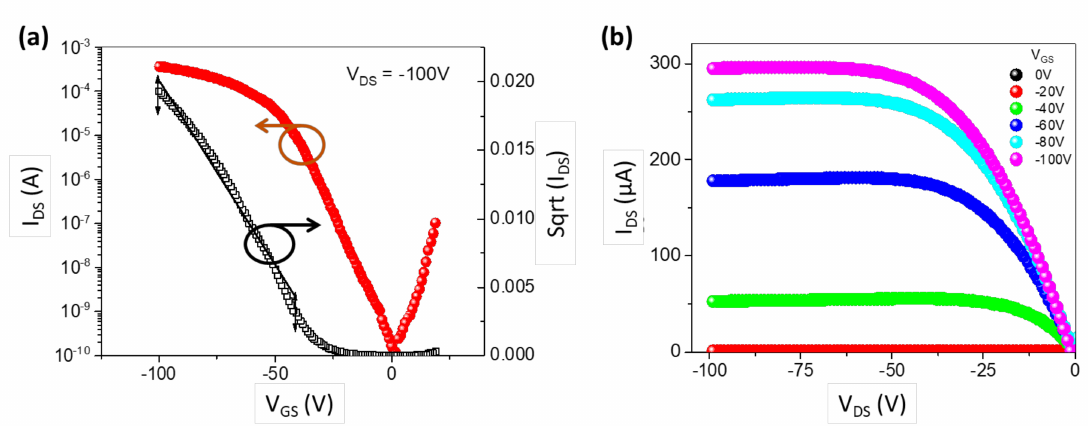
Figure 2. ( a ) Transfer characteristics of the light-emitting field-effect transistor (LEFET) (red) and the square root of the source-drain current (black) with a linear fit for channel length L = 100 µ m, and channel width = 2400 µ m. ( b ) Output characteristics of the p-type LEFET at various gate voltages.